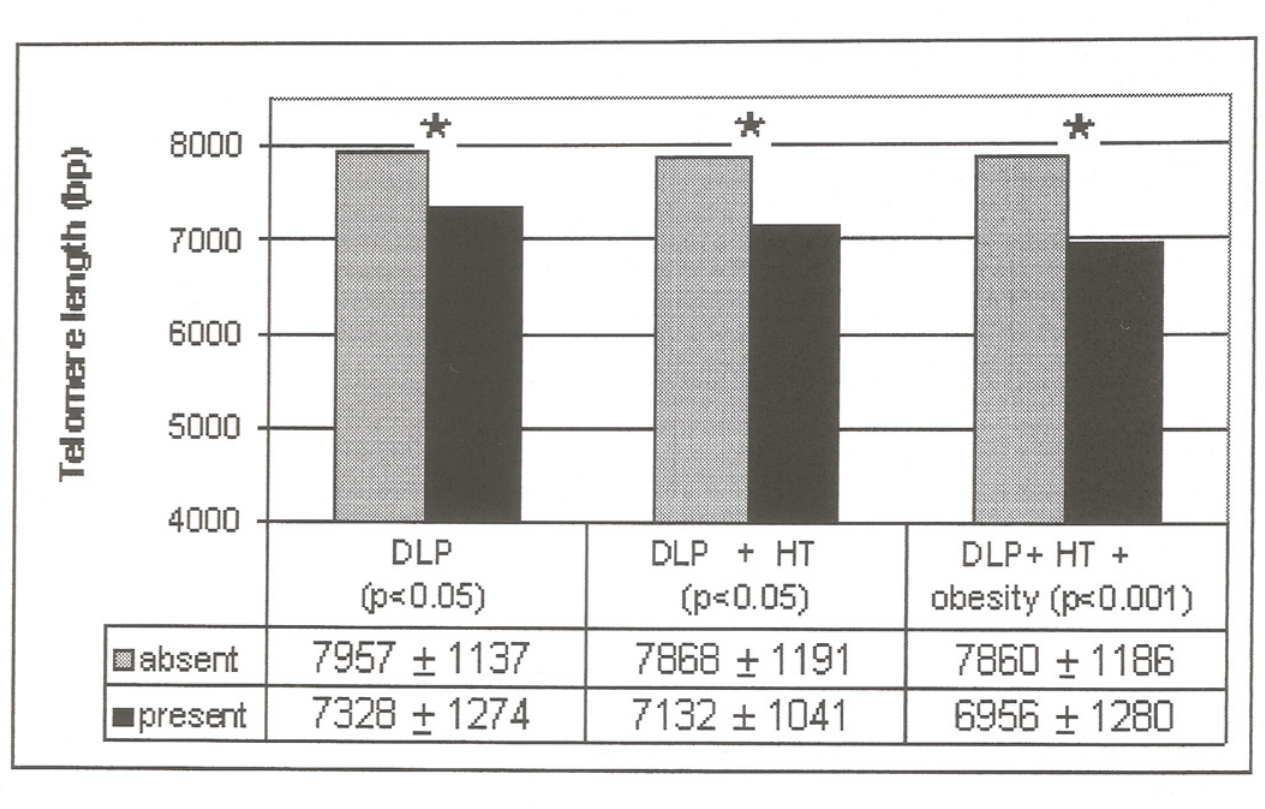
Fig 4. Mean Telomere length in patients with CS with several CVR factors. Dyslipidemic patients (n = 35) compared to those with normal lipids (n = 42); dyslipidemic and hypertensive patients (n = 21) compared to those who did not have both CVR factors (n = 56); patients with dyslipidemia, hypertension and obesity (n = 15) compared to those who did not have three CVR factors (n = 62). Abbreviations: DLP: dyslipidemia; HT: hypertension; bp: base pairs